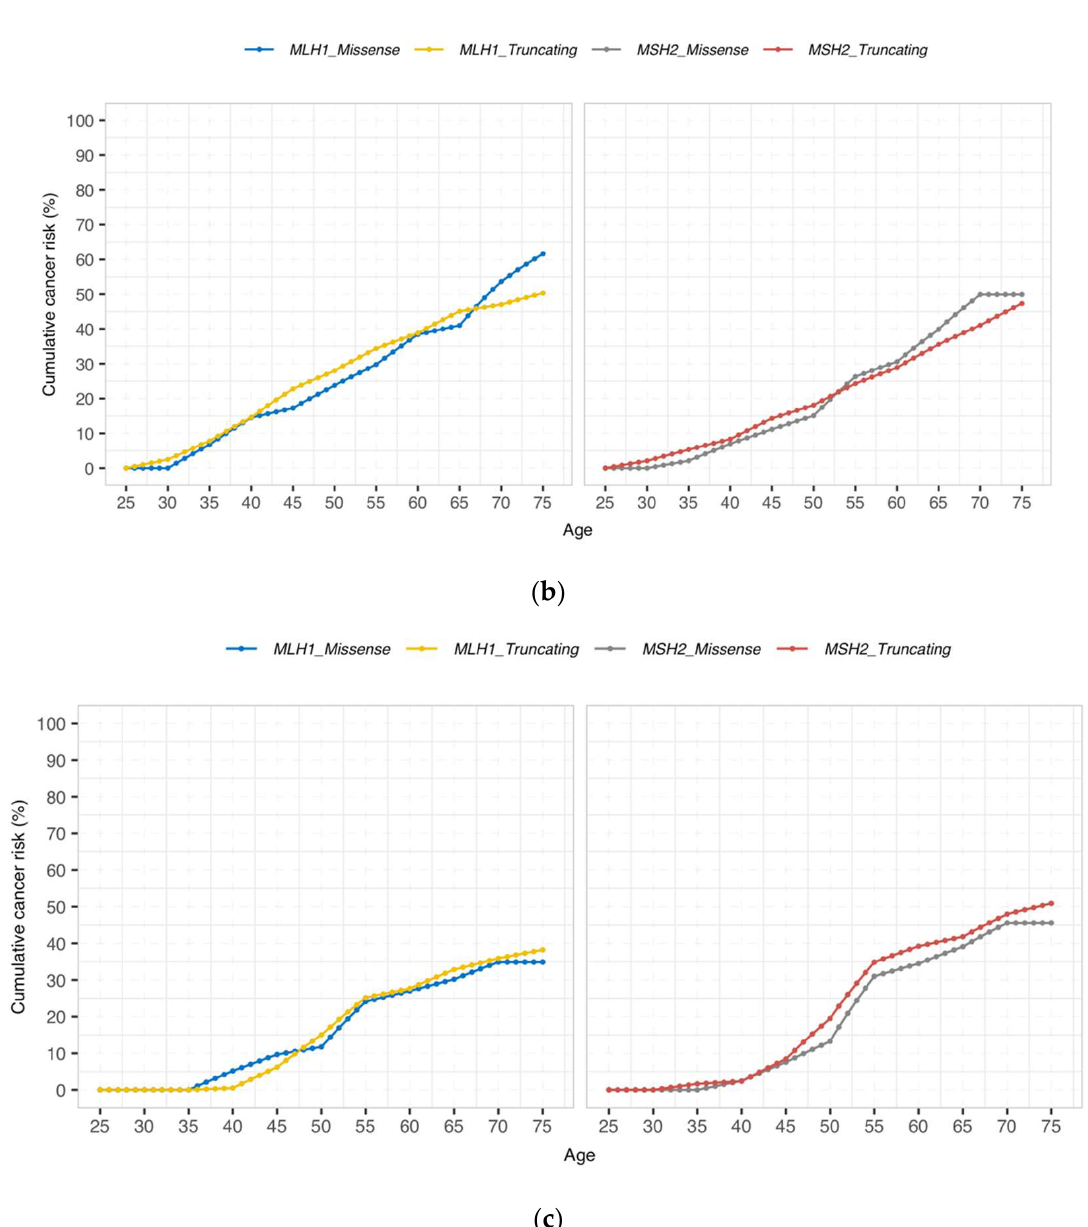
Figure 1. Cumulative incidence of ( a ) any cancer, ( b ) colorectal, and ( c ) endometrial cancer by gene and type of variant. There were no significant differences between carriers with missense/aberrant splicing versus truncating variants at any age in any groups ( p > 0.05 for all comparisons).